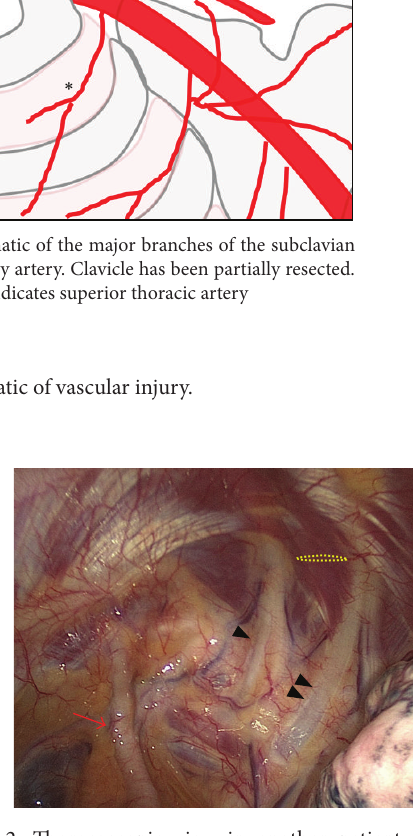
Figure 2: Thoracoscopic view in another patient showing the location of injury. Representative thoracoscopic view of left thoracic inletdemonstratingtheleftsubclavianartery(redarrow),first(black arrowhead) and second (double arrowheads) ribs, and the area of injury (yellow dotted line). The deflated lung is seen in the right lower quadrant. Superior =